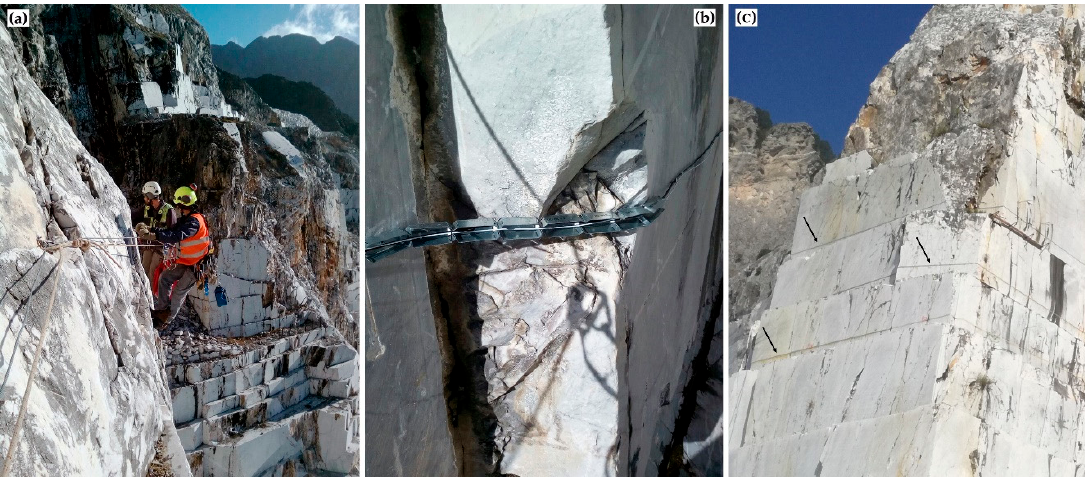
Figure 8. ( a ) Installation of the optical fiber on the marble buttress carried out by specialized climbing workers. ( b ) Detail of a special optical fiber setting, reinforced by metal elements, in an area characterized by artificial rock cut and fracturing. ( c ) The black arrows indicate the sensors (light grey lines) glued to the buttress.